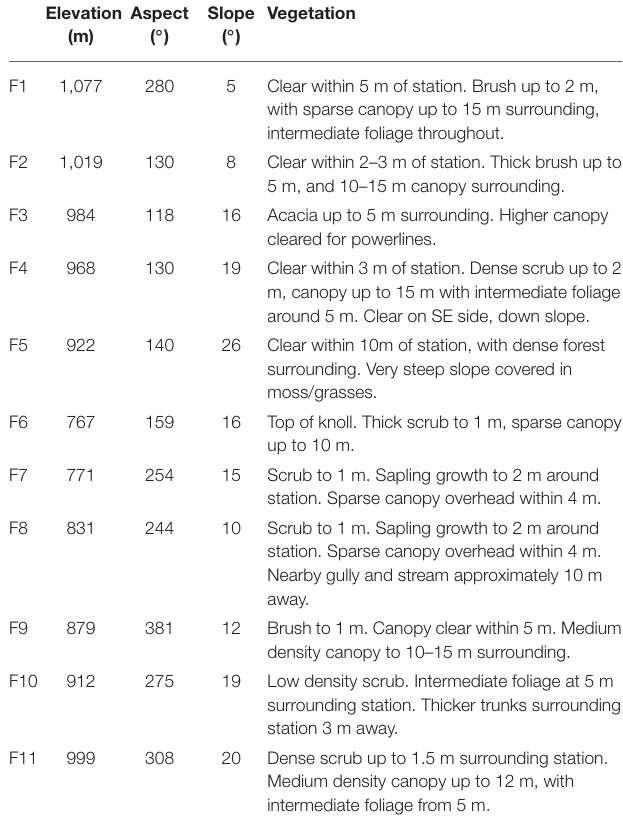
TABLE 1 | Topographic and vegetation details for each site across Flea Creek